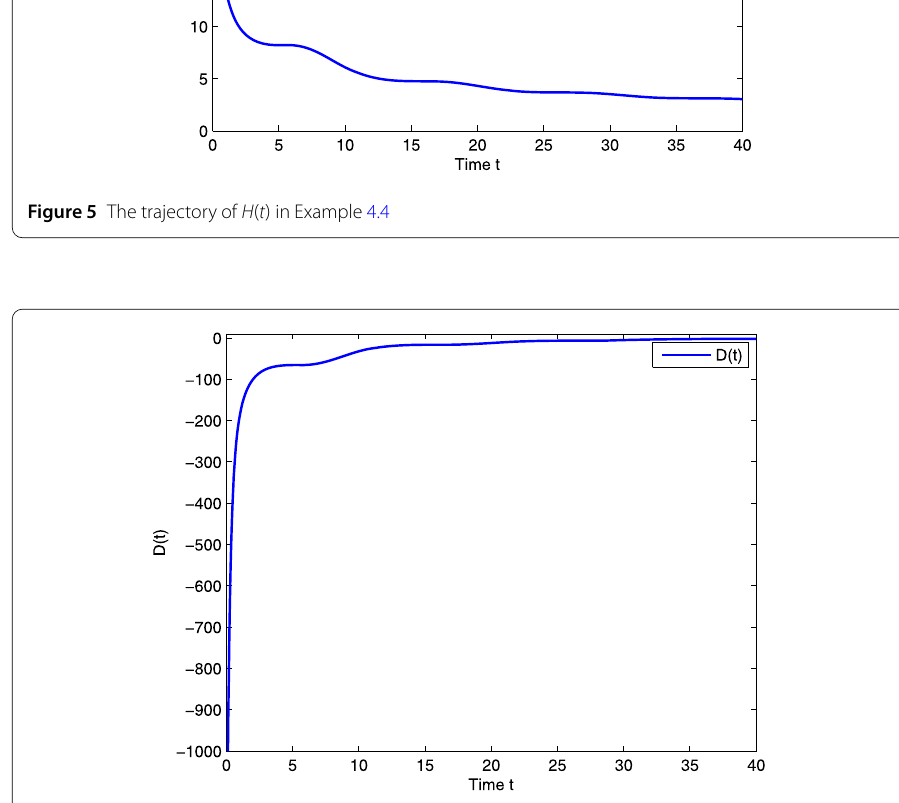
Figure 6 The trajectory of D ( t ) in Example